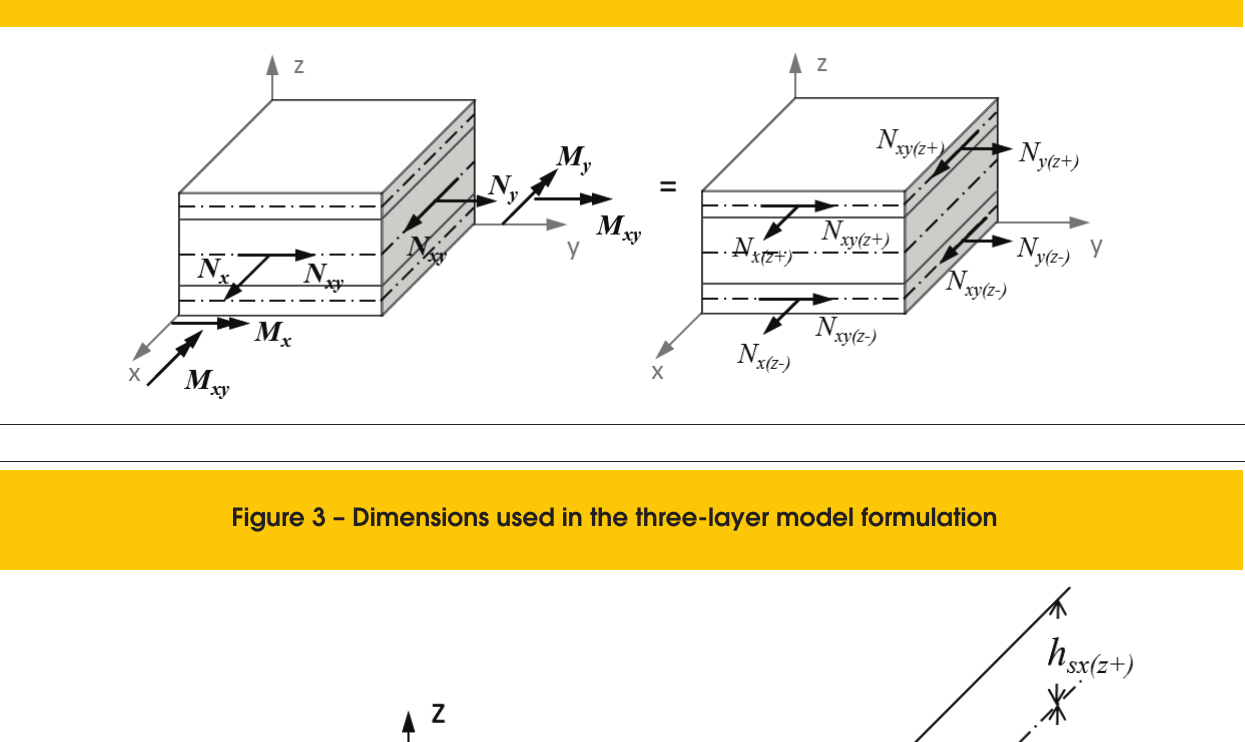
Figure 2 – Equilibrium between membrane forces in the outer layers and the shell active forces